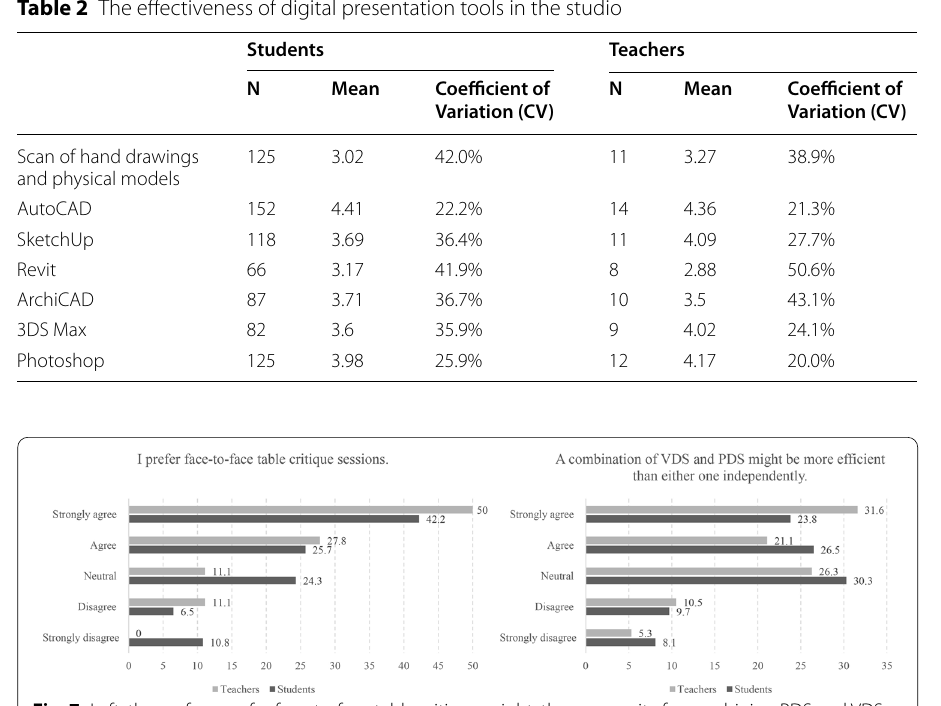
Fig. 7 Left, the preference for face-to-face table critiques; right, the propensity for combining PDS and